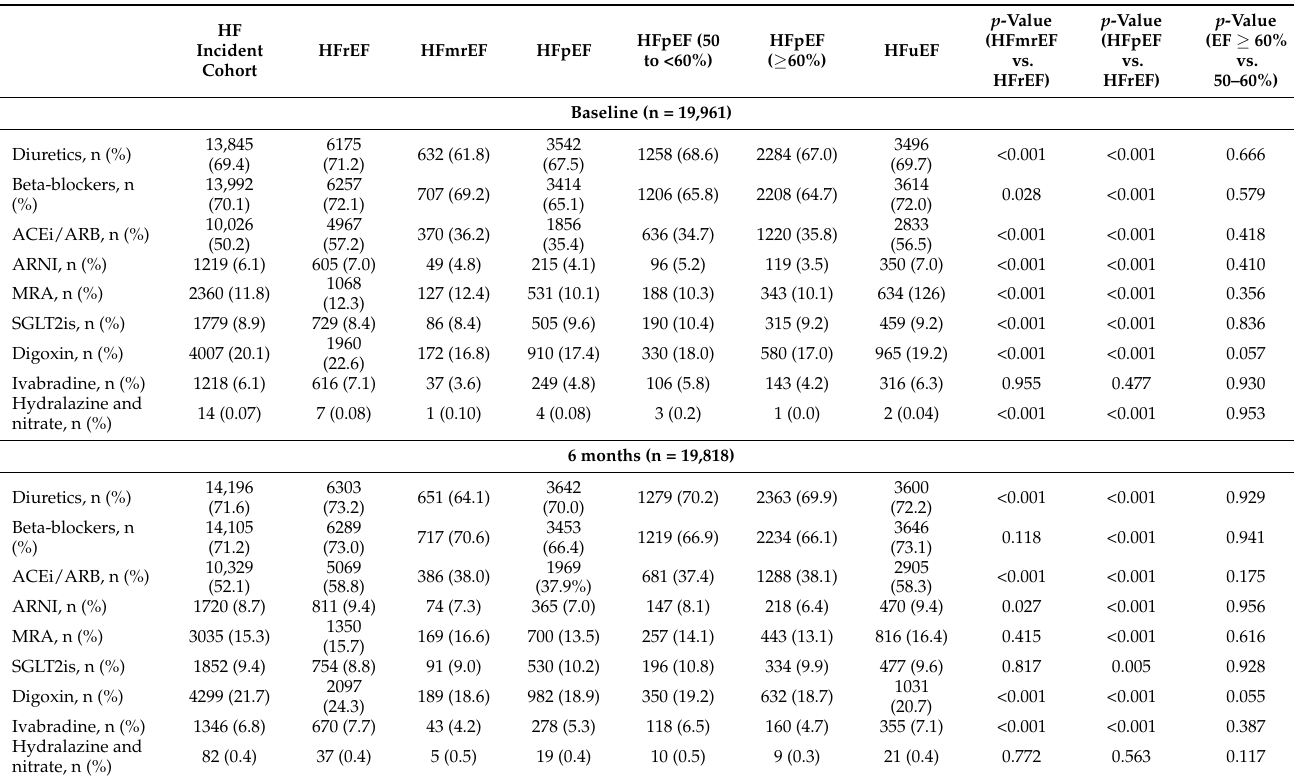
Table 2. Evolution of HF treatment in the incident HF cohort (index date